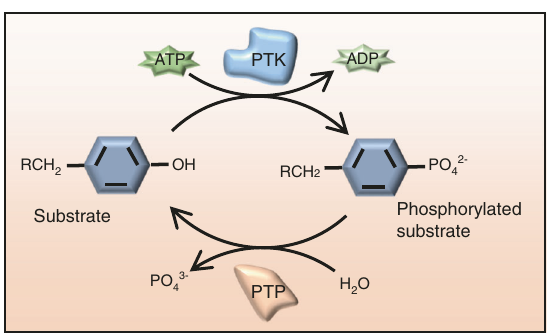
Fig. 1 Dynamic regulation of PYP by protein tyrosine kinases (PTKs) and protein tyrosine phosphatases (PTPs). PTKs and PTPs catalyze transfer of phosphate groups between substrates. PTKs catalyze transfer of γ -phosphate from ATP to its substrates and PTPs remove the phosphate group from a phosphoprotein. PYP modulates various biological functions of many types of cells, including OCs, bone and cartilage cells, and is the most prevalent mechanism of protein regulation. Aberrant PYP due to altered expression or activity of PTKs or PTPs is associated with uncontrolled cell proliferation, differentiation, and